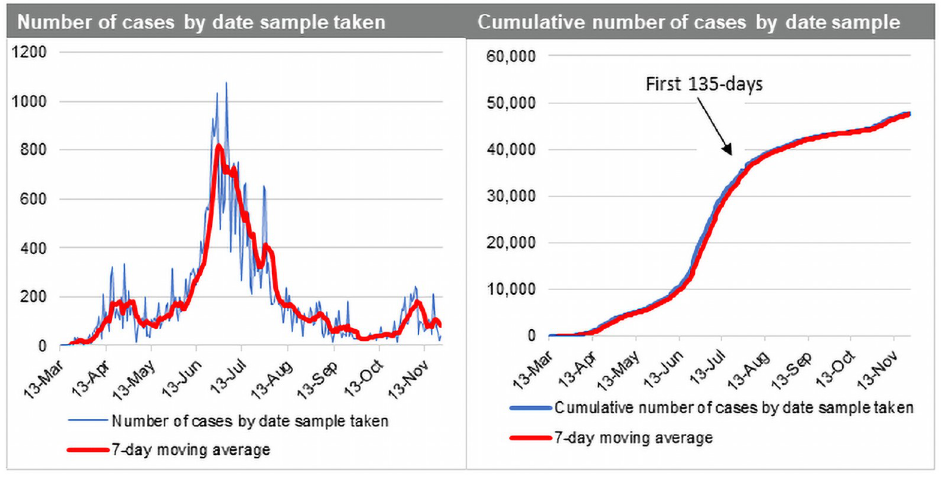
Fig 1. Ghana COVID-19 daily cases (Mar-Dec